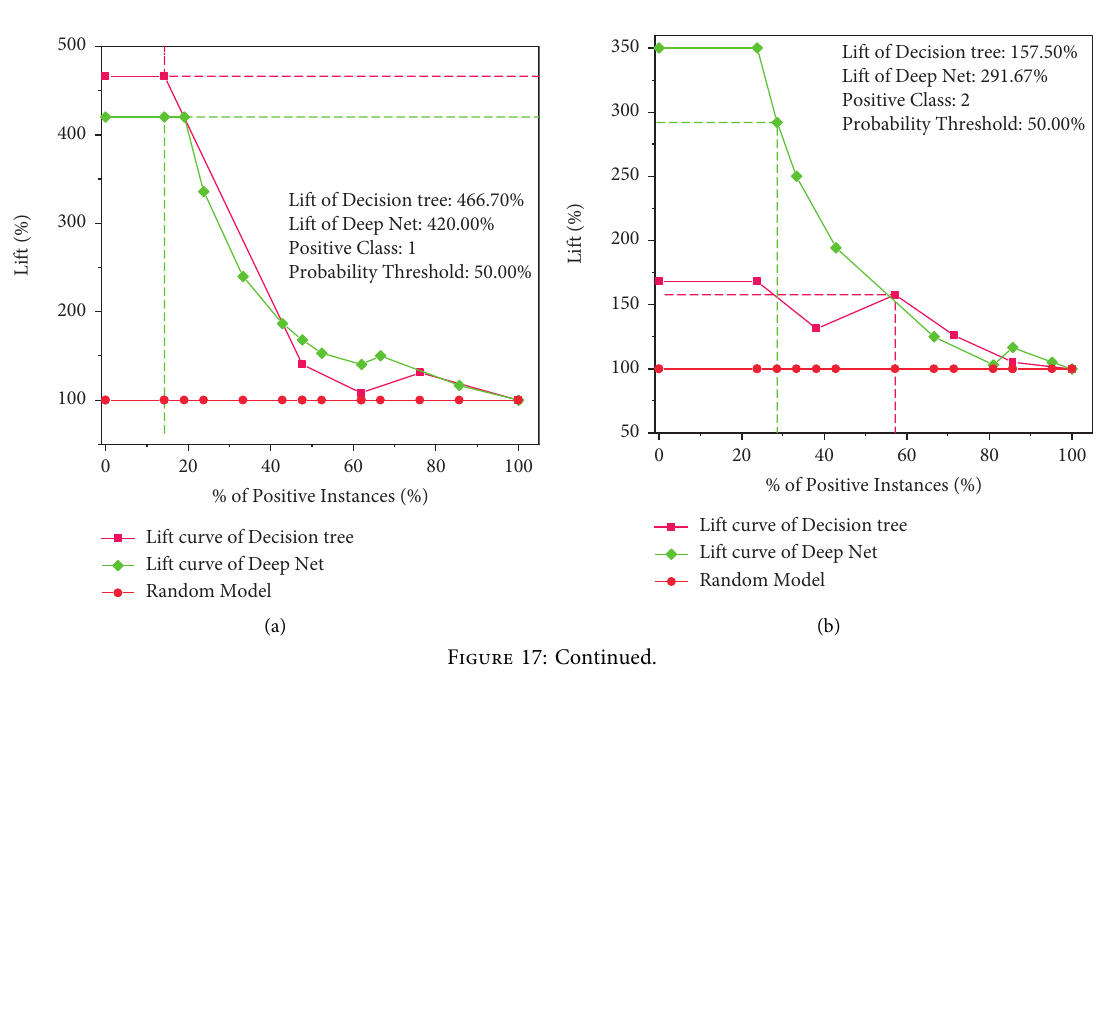
Lift of Decision tree: 466.70% Lift of Deep Net: 420.00%